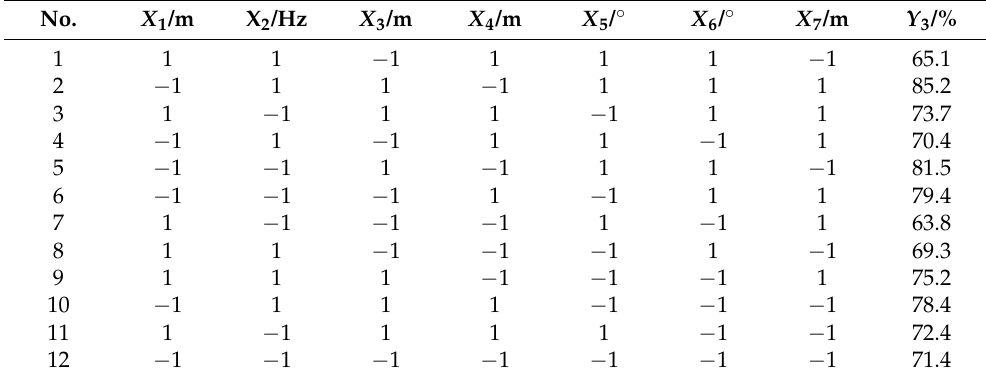
Table 4. Plackett–Burman experiment protocol and results. No. X 1 /m